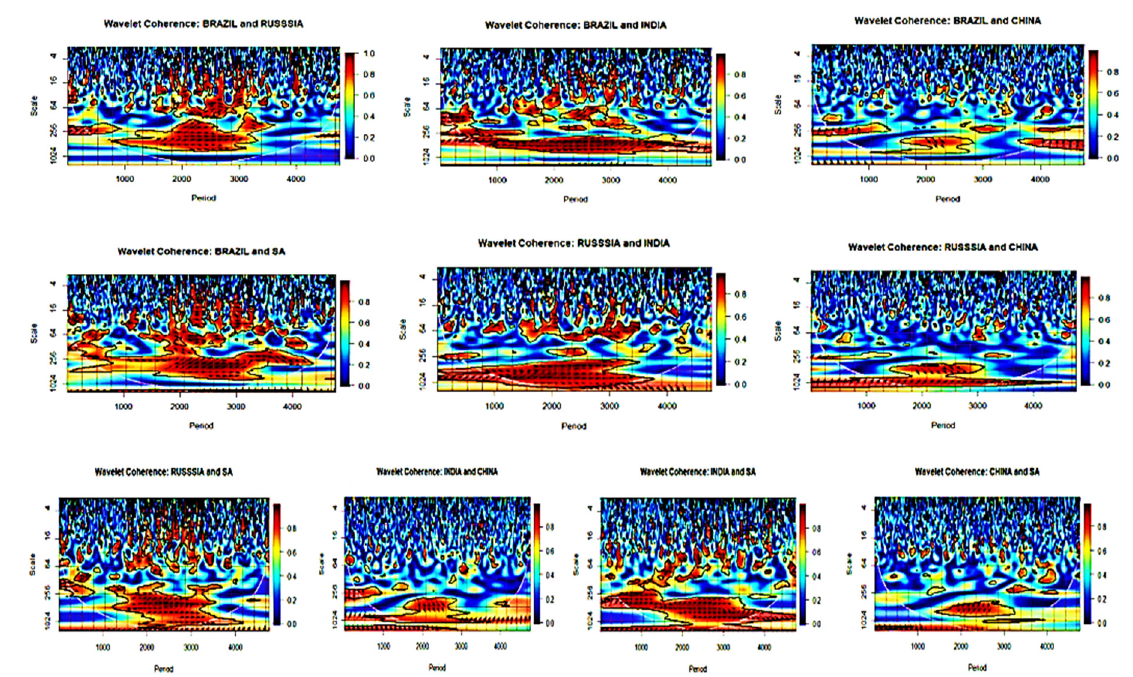
Figure 3. Wavelet coherence plot between the pairs (co-movement between the pairs).